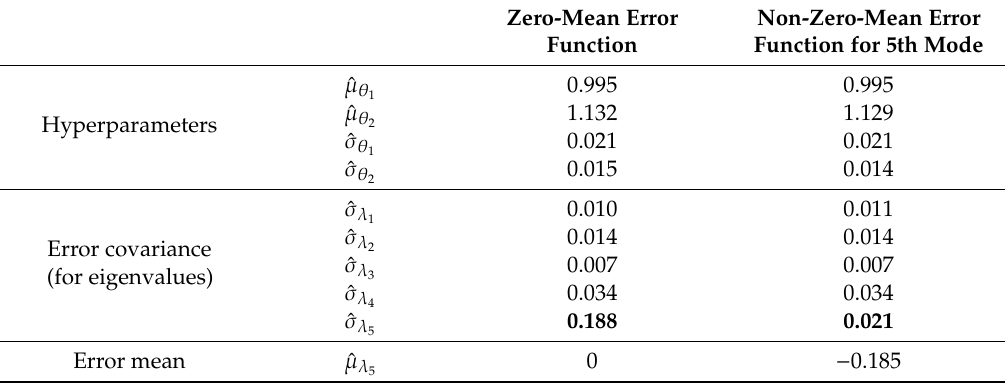
Figure 10. Model-predicted (gray) vs. identified (black) natural frequencies considering non-zero-mean error function for 5th mode, with the inclusion of error function. Table 2. MAP values of hyperparameters and error covariance for zero-mean and non-zero-mean error function cases (estimated error mean/bias is shown in last row).